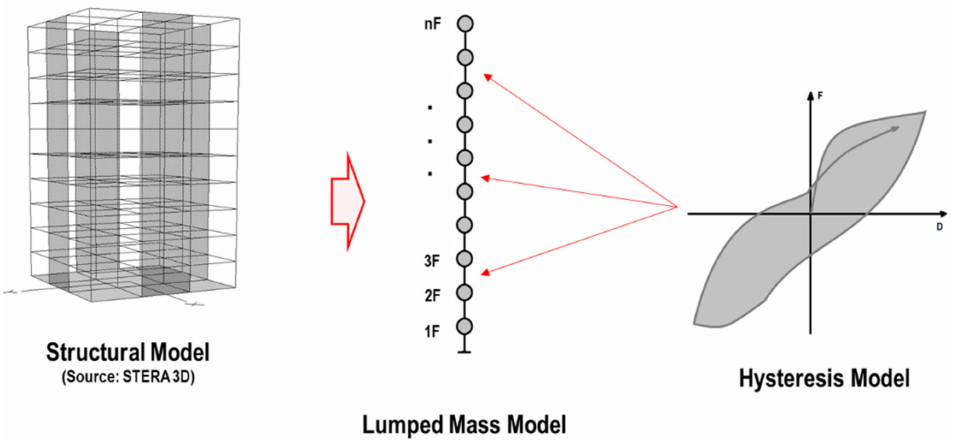
Figure 1. Structural